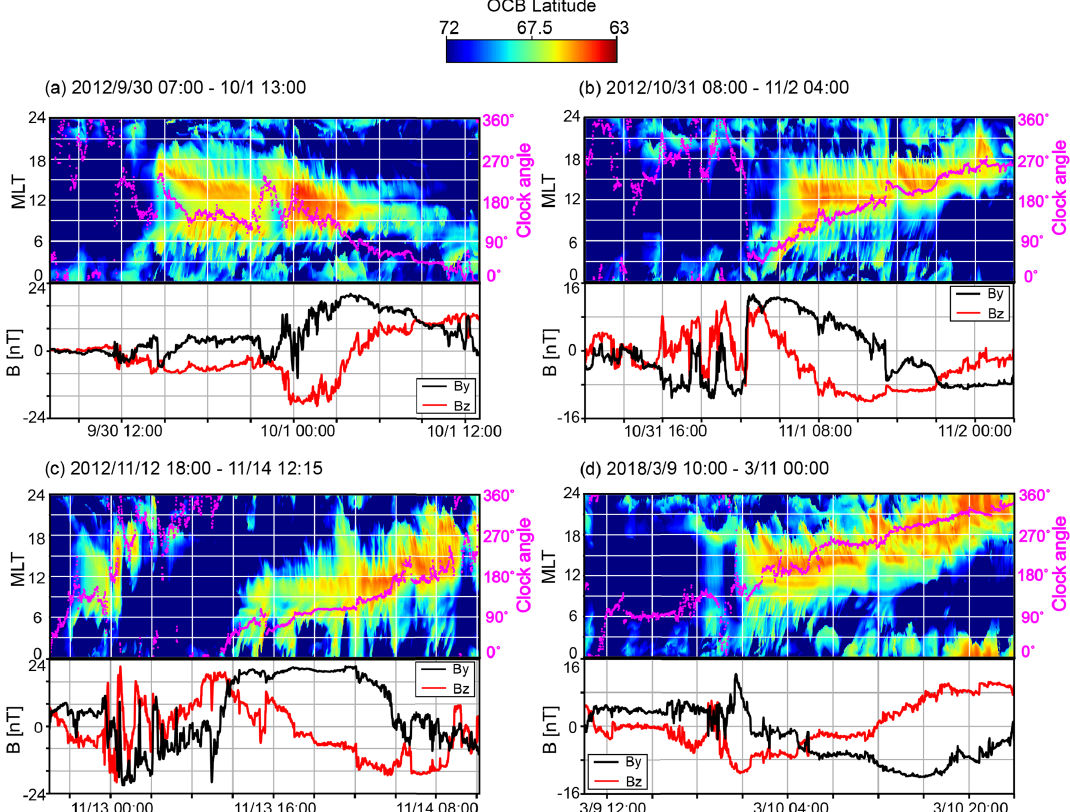
Figure 6. Modeled OCB dynamics during the four different geomagnetic storms. The color coding indicates the OCB latitude. Superimposed lines in magenta indicate the IMF clock angle, with the scale shown on the right side of each panel. Panels (b) , (b) , (c) and (d) show the B y (in black) and B z (in red) components of the IMF in GSE